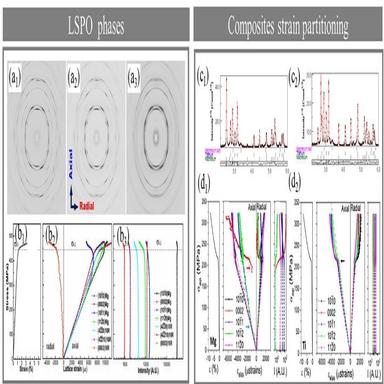
The changes of LSPO phases by in-situ SR-XRD: (a1–a3) Debye-Scherrer rings; (b1–b3) tensile stress-strain curves, lattice strain, and diffraction intensity ; (c1, c2) the (c1) axial and (c2) radial diffraction patterns as a function of 2θ; (d1, d2) compressive true stress-true strain curves, axial and radial internal strains as a function of the applied stress and evolution of the integrated intensity .